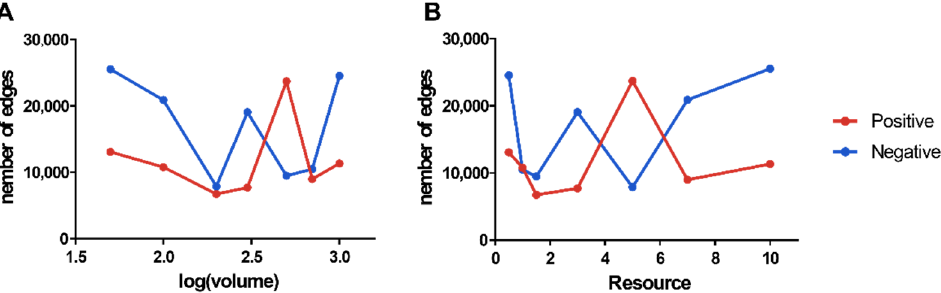
Figure 10. Plot of the number of microbial interactions network edges versus microcosm volume and resources. ( A ) shows the number of interactions network edges versus microcosm volume; ( B ) shows the number of interactions network edges versus